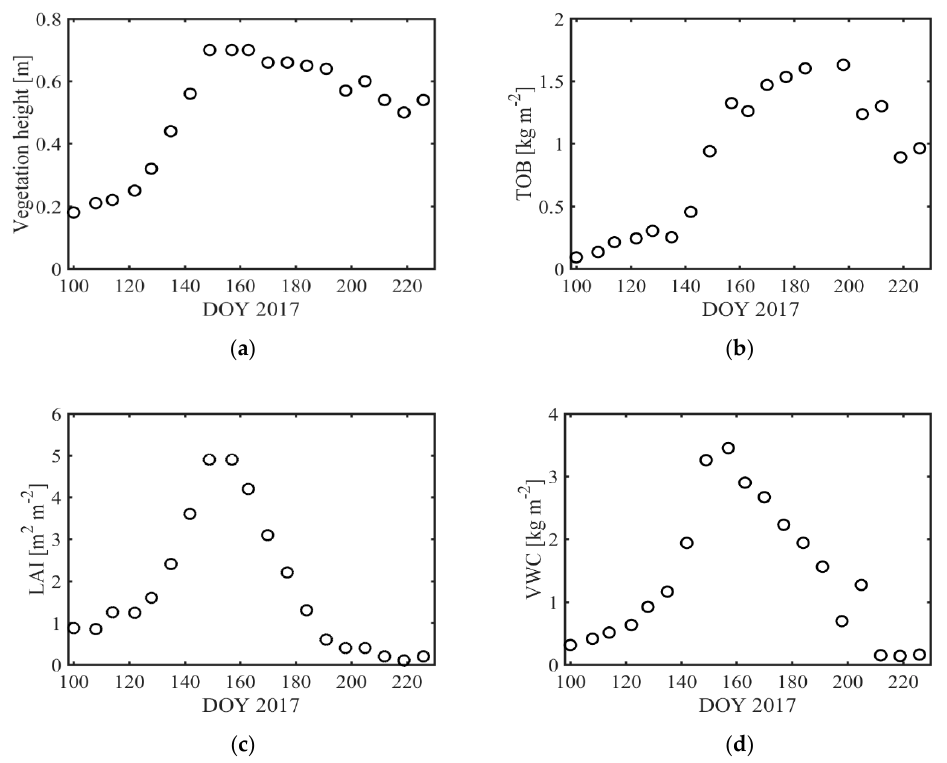
Figure 4. Weekly measured vegetation height (m) ( a ), total of aboveground biomass (TOB) (kg m − 2 ) ( b ), leaf area index (LAI) (m 2 m − 2 ) ( c ), and vegetation water content (VWC) (kg m − 2 ) ( d ).